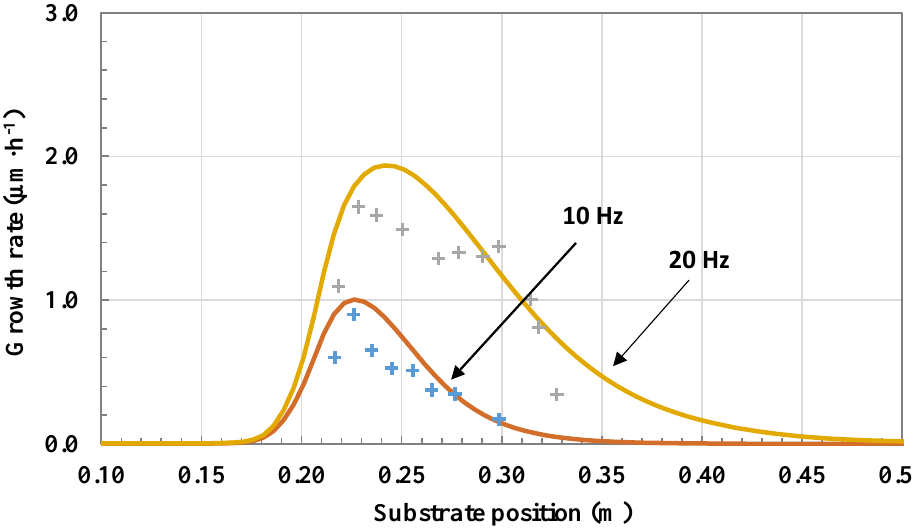
Figure 6. Comparison of calculated ( − ) and measured ( + ) growth rate of chromium carbide on the 20 cm substrate in the conditions of Table 4 (Run 1 and 2).